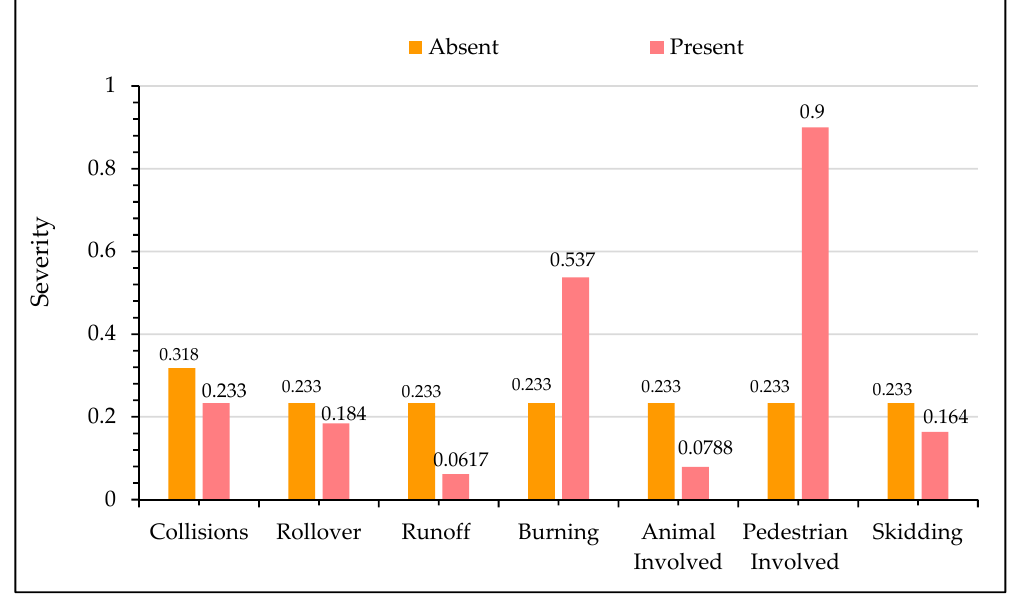
Figure 8. Effect of crash characteristics on crash severity. Figure 8. E ff ect of crash characteristics on crash